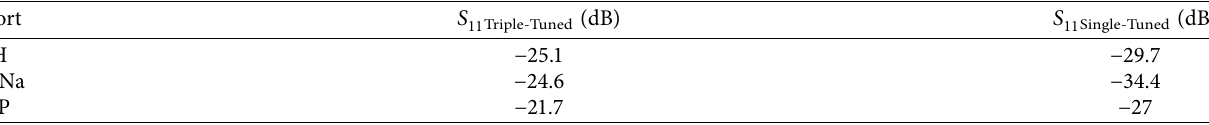
Table 4: Triple-tuned birdcage/saddle pair matching/tuning